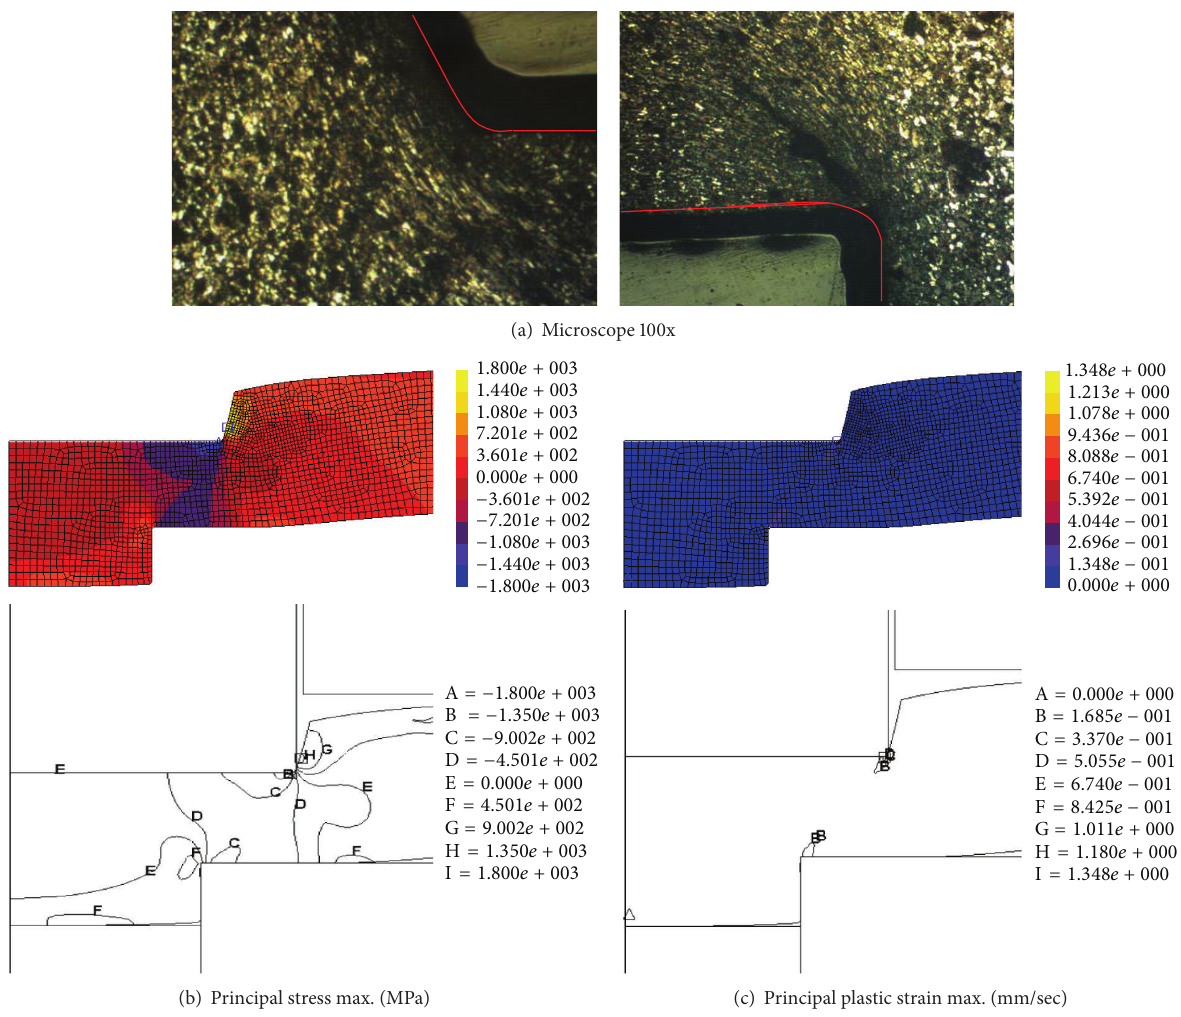
Figure 9: Microstructure behavior analysis for 40% punch